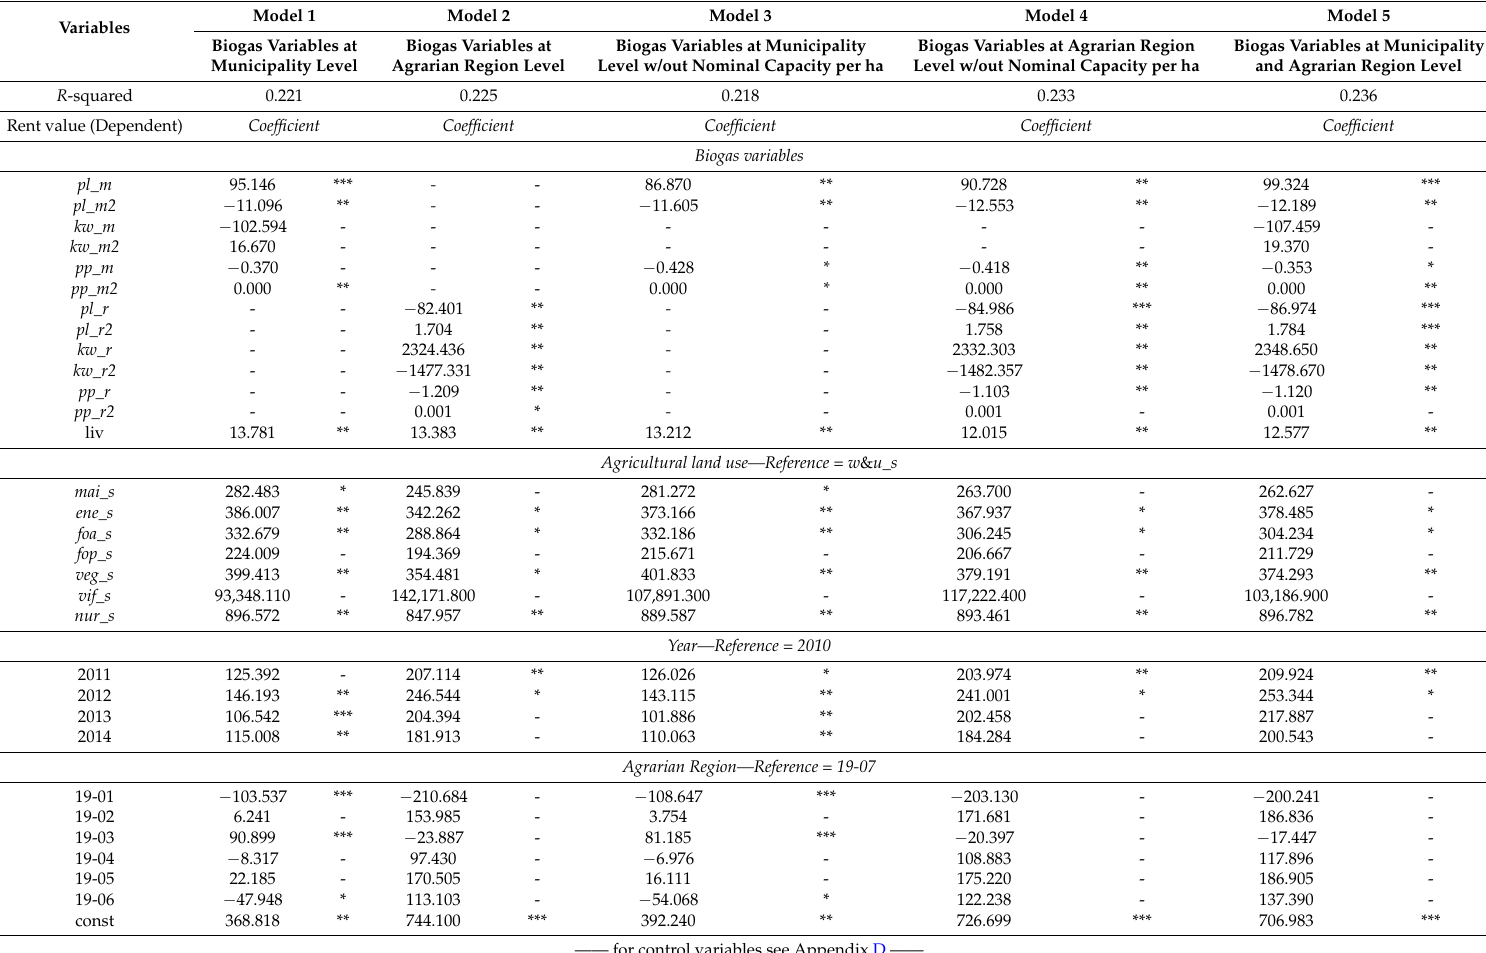
Table 2. Explanatory variables for land rental price per year in ordinary least squares (OLS) models.